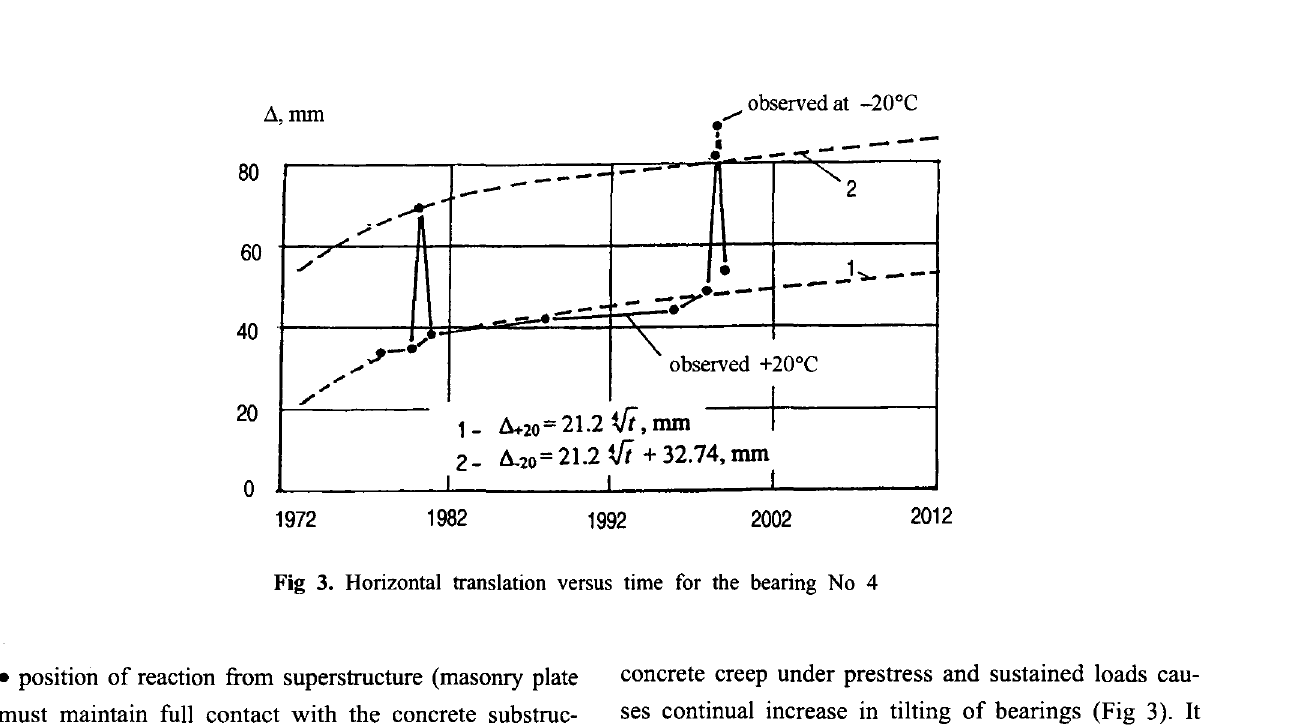
Fig 3. Horizontal translation versus time for the bearing No